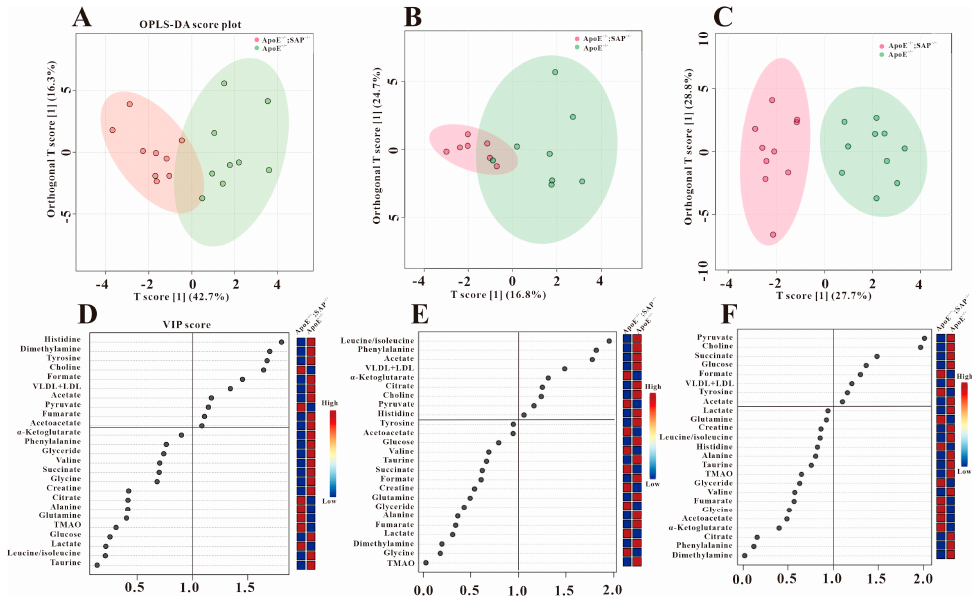
Figure 4. Metabolic differences between ApoE − / − ;SAP − / − and ApoE − / − groups at three periods. OPLS − DA scores plots ( A ) (8 w), ( B ) (8 + 4 w), ( C ) (8 + 8 w) and VIP scores ( D ) (8 w), ( E ) (8 + 4 w), ( F ) (8 + 8 w).